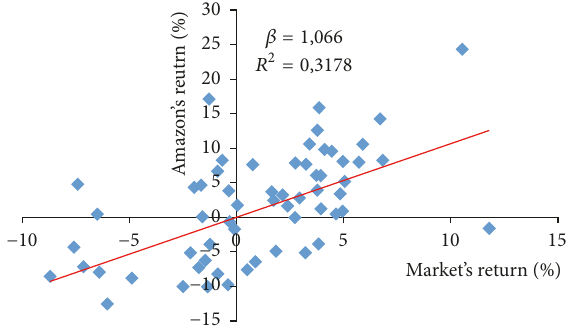
Figure 1: An example of Beta estimation. Source: elaborated by the authors based on Brealey et al.